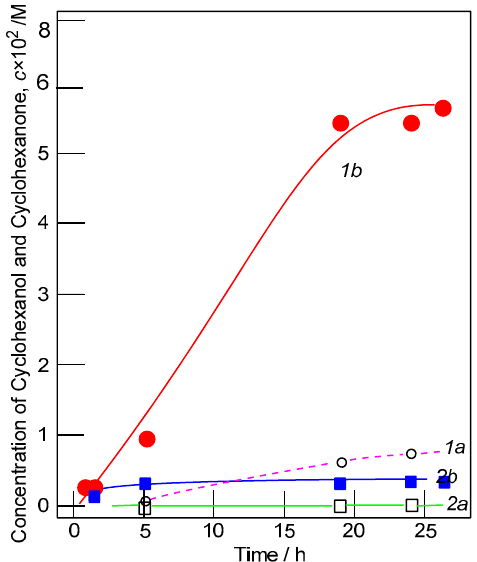
Figure 1. Compound 1 in the absence (curves a) and in the presence of PCA; (curves b) in MeCN at 25 °C. catalyzed the oxidation of cyclohexane by H 2 O 2 (0.59 M) Accumulation of cyclohexanol (curves 1b) and cyclohexanone (curves 2b) (concentrations were measured after the reduction with PPh 3, used method by Shul’pin, which is in comparison with the concentrations of alcohol and ketone in solution samples before and after adding PPh 3 ) are shown. The data are adapted from [19], Copyright (2004) with permission of Wiley.